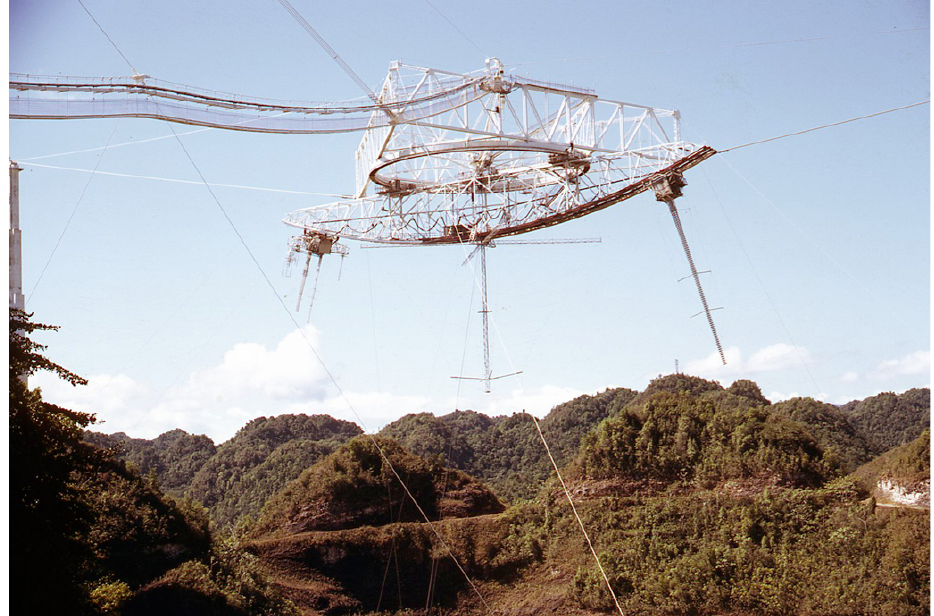
Figure 6. The Arecibo Observatory feeds in July 1972. The new 430MHz linefeed is mounted on carriage house #1 to the right in this photo. In the center is the HF log-periodic feed for ionospheric heating experiments. To the left is carriage house #2 with various radio astronomy feeds including those at 318MHz (left, 40 feet long), 611MHz (right, 45 feet long), the far-right feed is likely 1667MHz test feed while the feeds at the far left are likely nested Yagis at 111MHz and 196MHz (D. B. Campbell, personal communication, 2013). Note the catwalk at the upper left of the photo. Photo courtesy of Cornell University and Arecibo